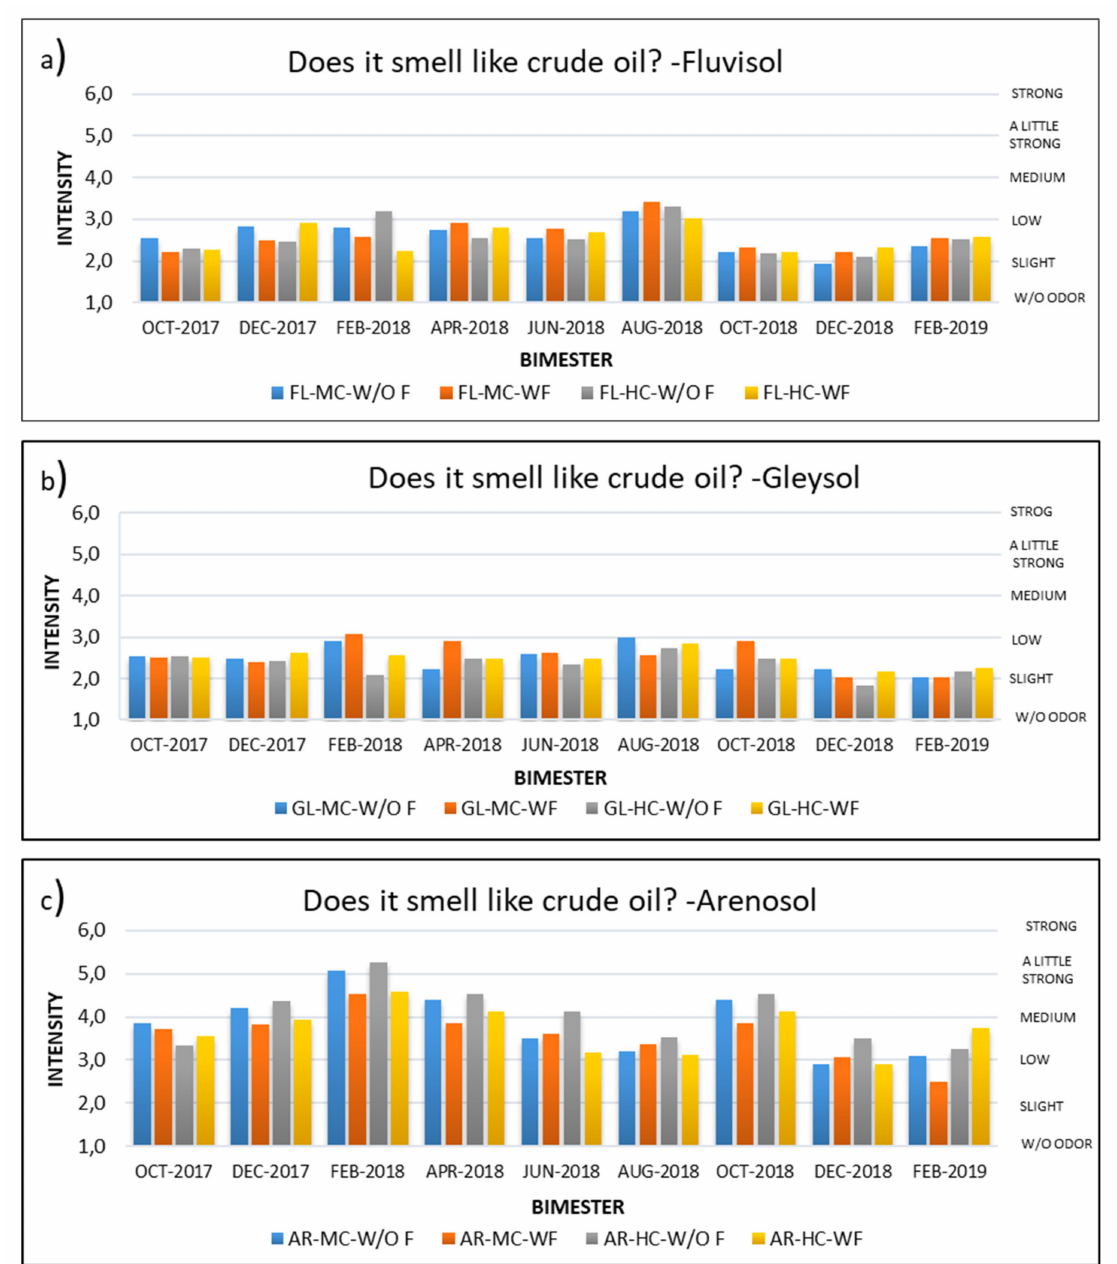
Figure 2. Intensity of petroleum odor in soil. a ) In Fluvisol, b ) in Gleysol, c ) in Arenosol. Values are averages of three replicates. FL = Fluvisol; GL = Gleysol; AR = Arenosol; MC = Medium Crude Oil; HC = Heavy Crude Oil; W / O F = Without Fertilizer; WF = With